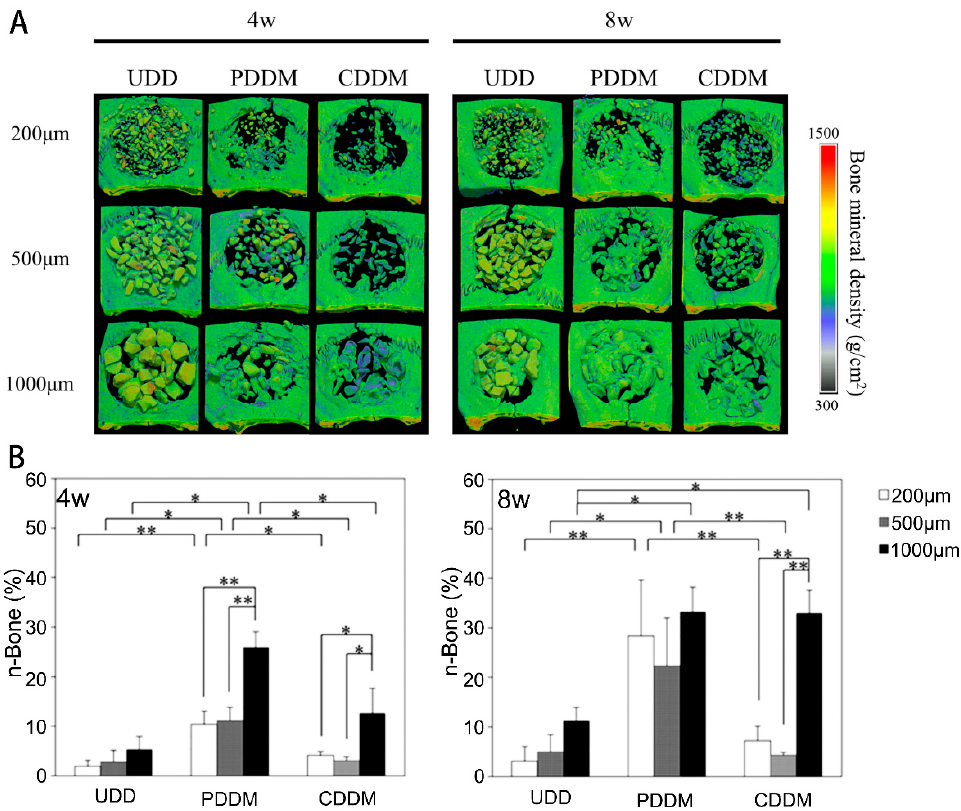
Figure 2. The dentin matrix-induced bone formation depended on the degree of demineralization and particle size. ( A ) Micro-CT analysis. New bone formation was enhanced in all particle sizes in PDDM groups, more than in CDDM groups. The results of 1000 µ m PDDM were especially noteworthy. In contrast, in UDD groups, much less new bone formed, and defects were occupied by dentin particles. ( B ) Newly formed bone (n-Bone%) were quantitatively evaluated. At 4 weeks, there is significant difference of n-Bone% between the PDDM and other groups in each particle size. At 8 weeks, there is a significant difference of the n-Bone% between the PDDM and the other groups in the 200 and 500 µ m samples. (From Takamitsu [17] in PLOS ONE , with permission.)